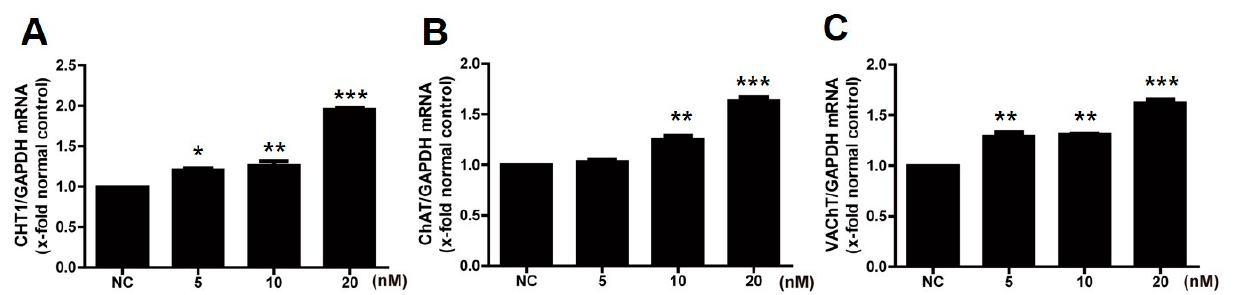
Figure 1. Expression of CHT1 ( A ), ChAT ( B ), and VAChT ( C ) in primary forebrain neurons after treatment with estradiol. Gene expression was analyzed by real-time PCR. CHT1; choline trans- porter1, ChAT; choline acetyltransferase, VAChT; vesicular acetylcholine transporter. * Significantly different from normal control ( p < 0.05).** Significantly different from normal control ( p < 0.005). *** Significantly different from normal control ( p < 0.001).